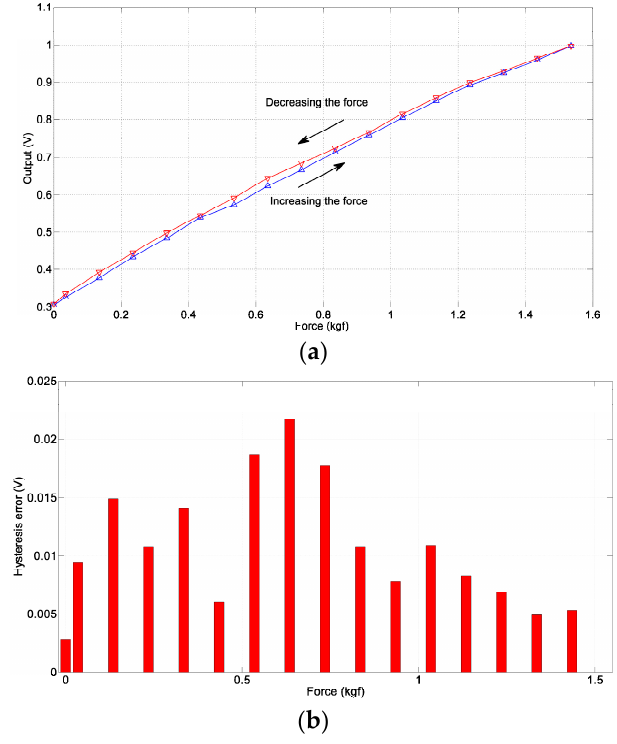
Figure 6. The hysteresis of the sensor. ( a ) The hysteresis curve; ( b ) The hysteresis error.